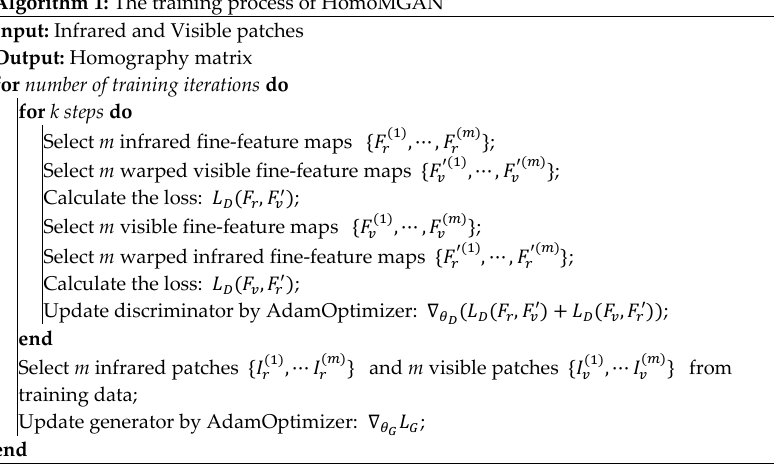
Figure 2. The architecture of the proposed HomoMGAN for homography estimation of infrared and visible images. Our network architecture consists of four modules: a shallow feature extraction network (infrared shallow feature extraction network f r ( · ) and visible shallow feature extraction network f v ( · ) ), a generator, and a discriminator. Algorithm 1: The training process of HomoMGAN